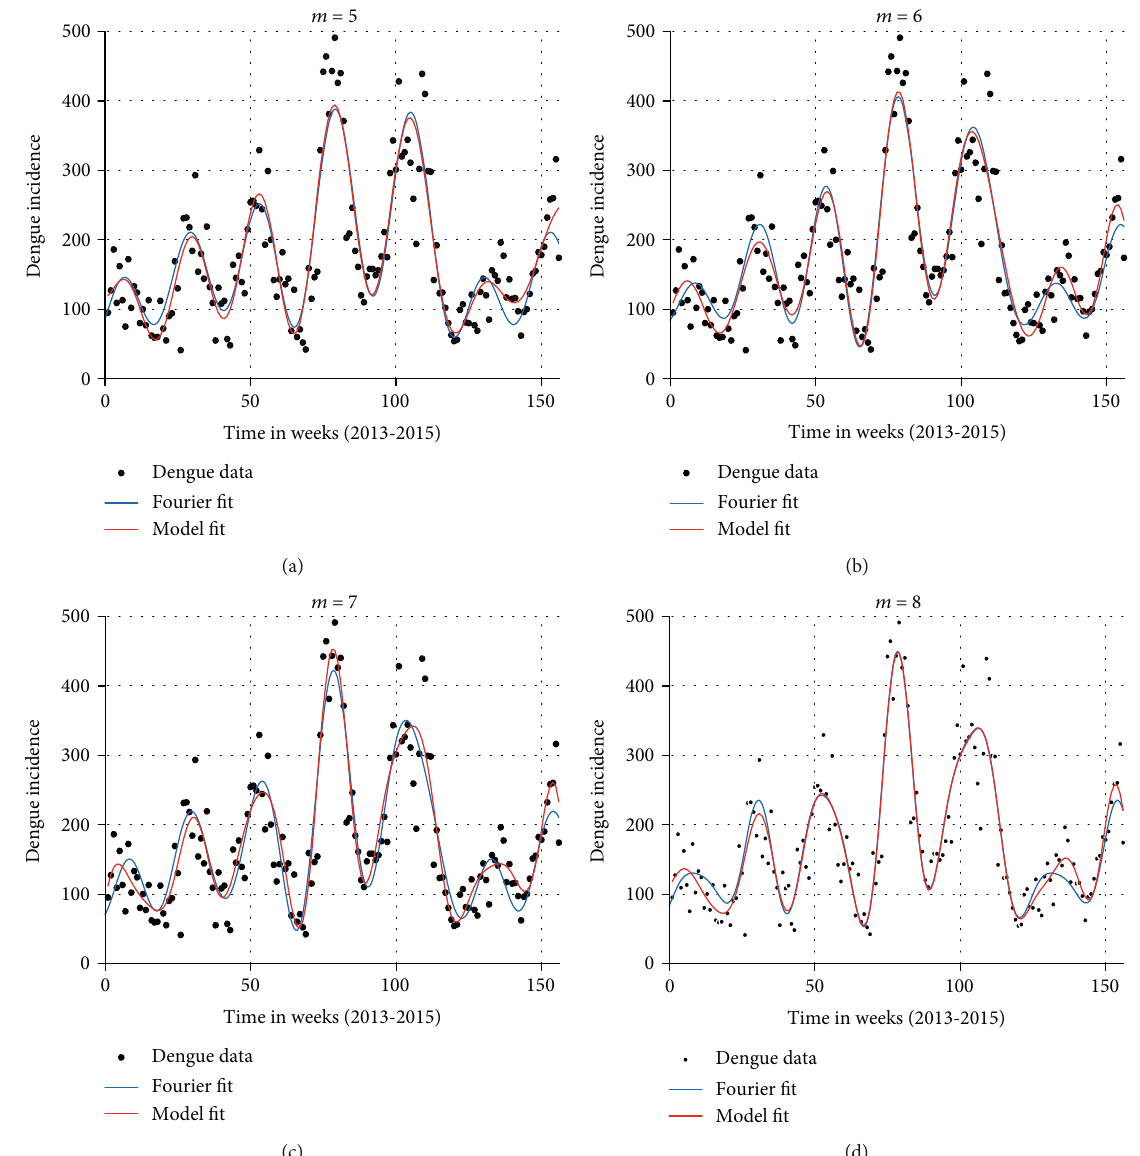
Figure 1: Dengue incidence data (dots), Fourier fi t (blue curve), and model fi t (red curve) for m = 5, 6, 7, 8